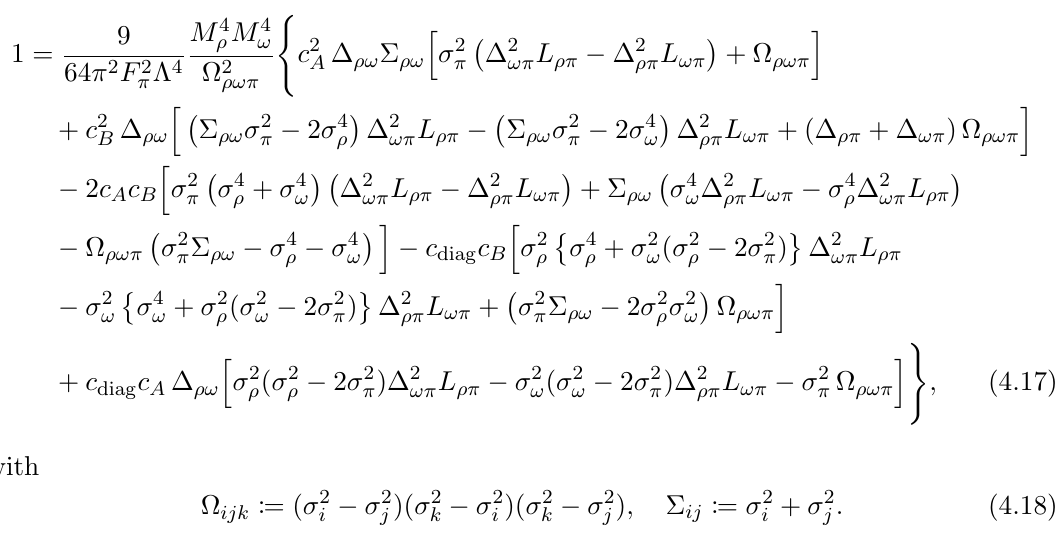
Table 1. \Natural" model parameters of the large- N c Regge models for the pion, (cid:17) , and (cid:17) 0 TFFs. Note that here we rescaled the (cid:17) ( 0 ) parameters c A , c B , and c BL with a factor of C (cid:17) ( 0 ) The second SDC concerns the limit Q 2 and c , but now in a di(cid:11)erent combination together with c B